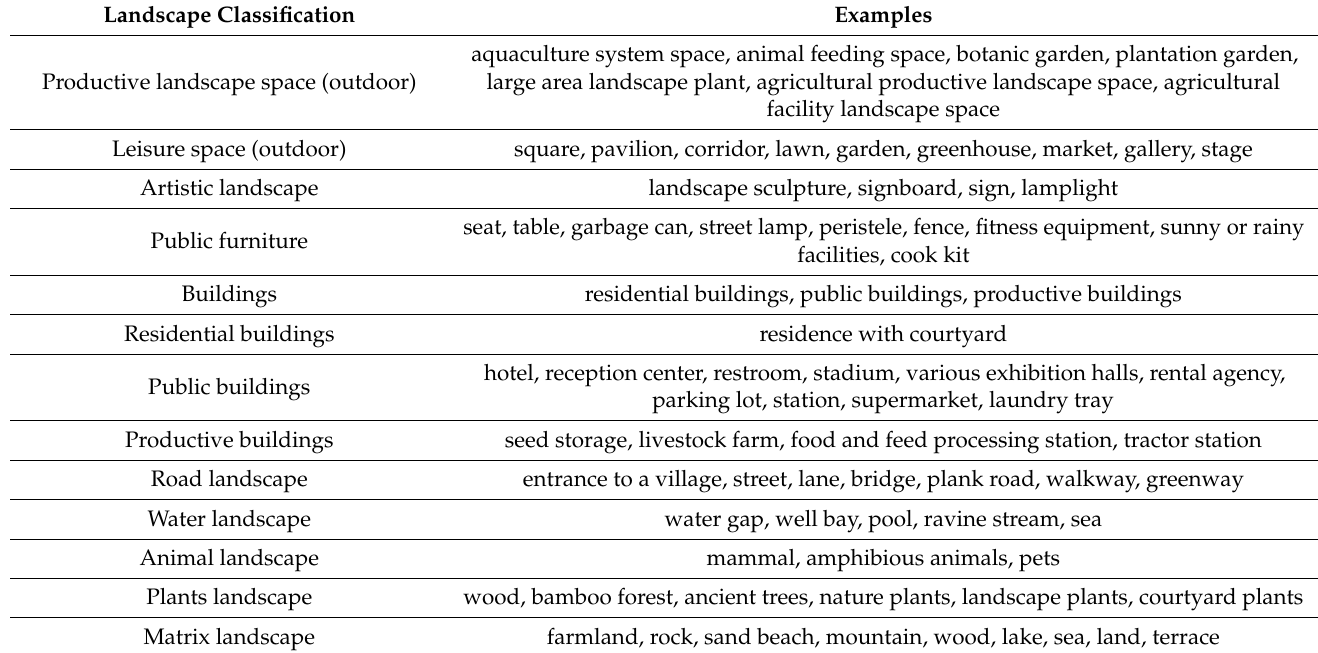
Table A1. Landscape Classification in Rural Places and